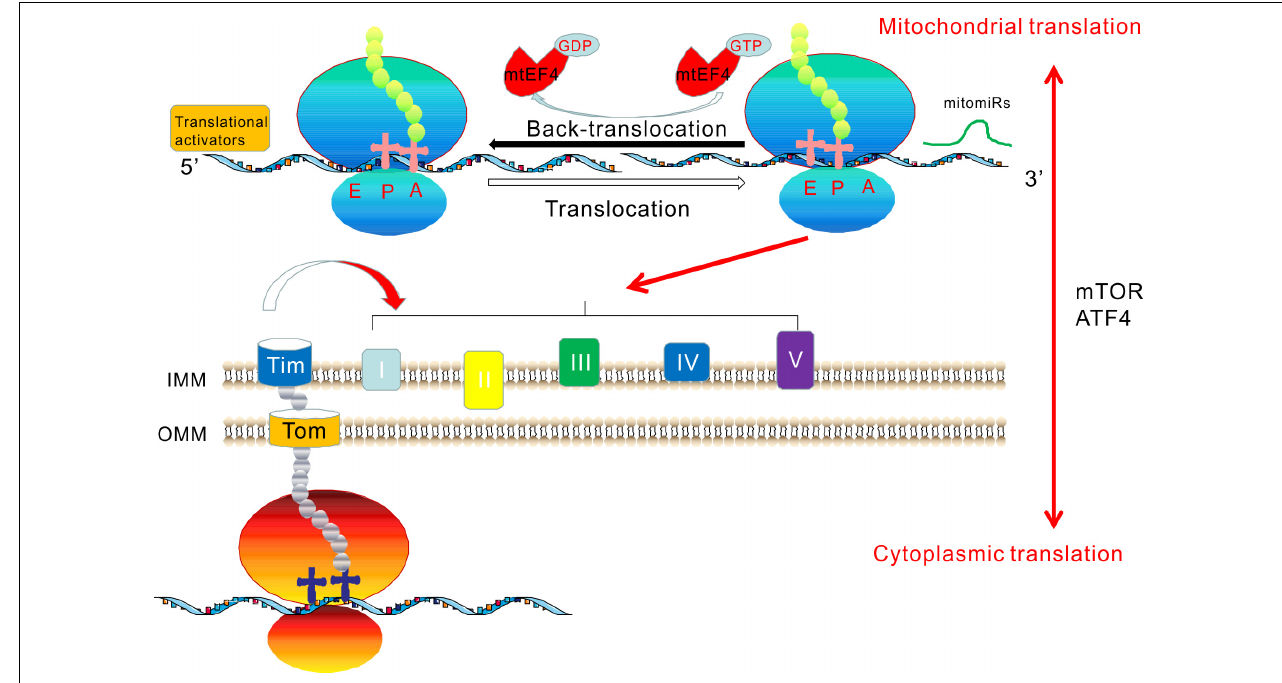
FIGURE 2 | Crosstalk between mitochondrial and cytoplasmic translation. mtEF4, translation activators, and mitomiRs are important regulators that directly affect mitochondrial translation. The components of mitochondrial complexes I, II, III, IV, and V are produced by both mitochondrial and cytoplasmic translation, requiring coordination between the two translation systems. mtEF4 has a back-translocation effect and catalyzes the back-translocation of the P- and E-tRNAs to A- and P-tRNAs. Mitochondrial translation activator promotes mRNA-specific translation initiation. MitomiRs function at the 3 (cid:48) end of mRNA. mTOR and ATF4 play an important role in the crosstalk between mitochondrial and cytoplasmic translation.